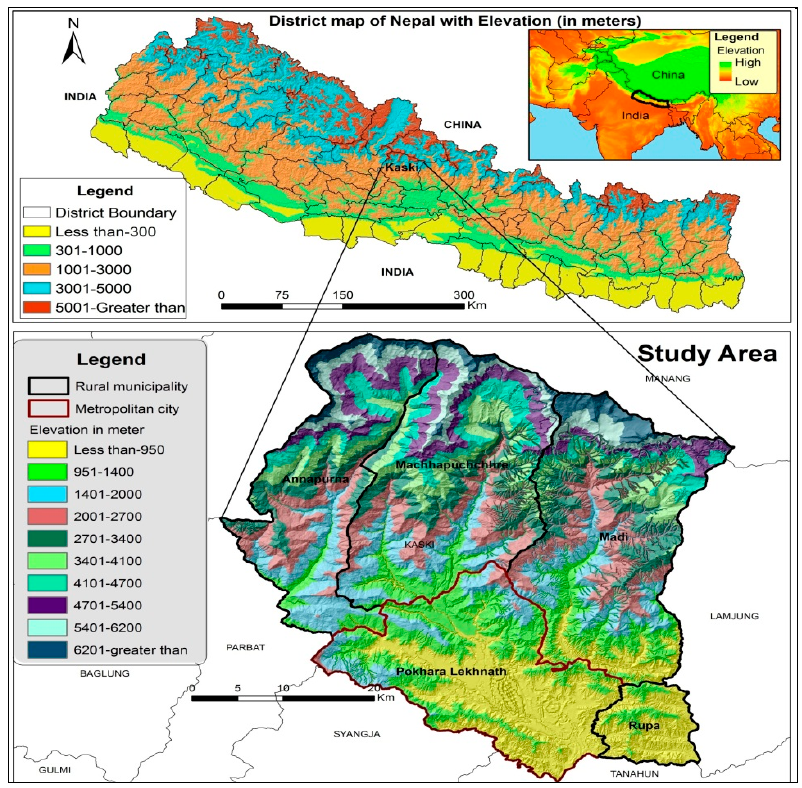
Figure 1. Location map of the study area.